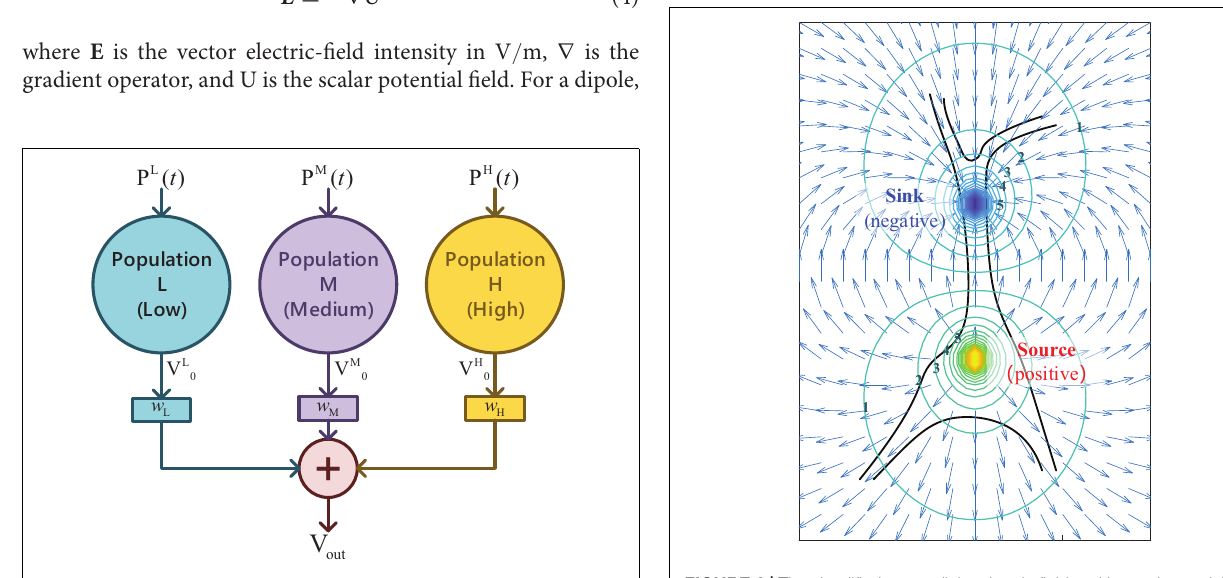
FIGURE 4 | Parallel feedforward schema of triple populations.